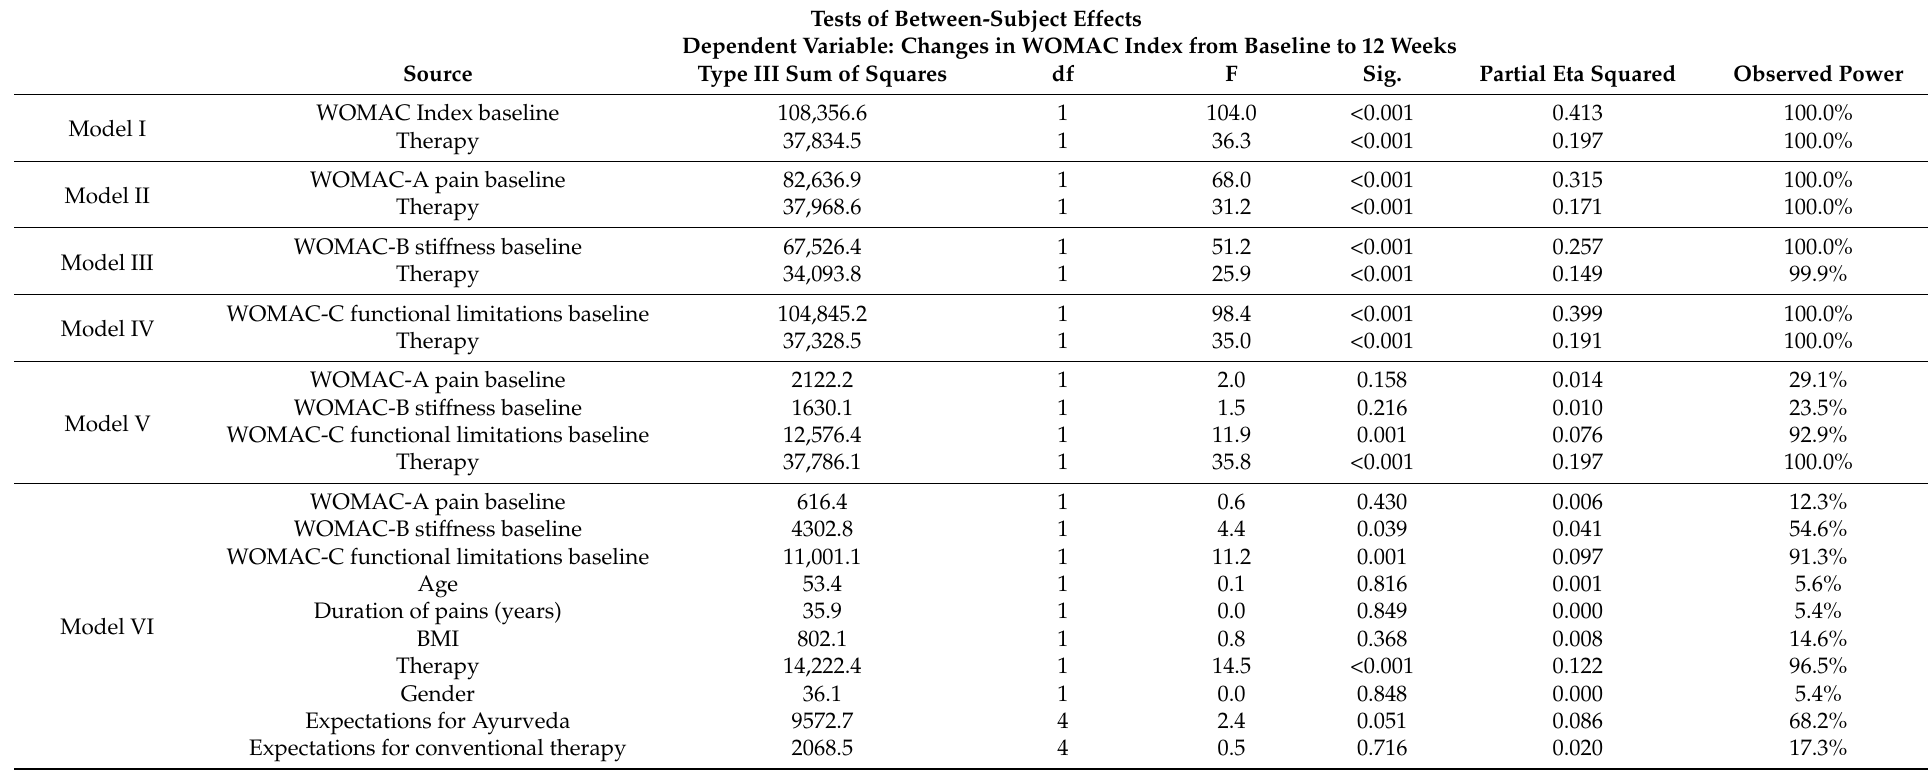
Table 3. Significance, partial eta squared, and observed power for the independent variables in various generalized models (tests of between-subject effects). Therapy and functional limitations were the only significant predictors for the WOMAC Index from baseline to 12 weeks in all models with WOMAC